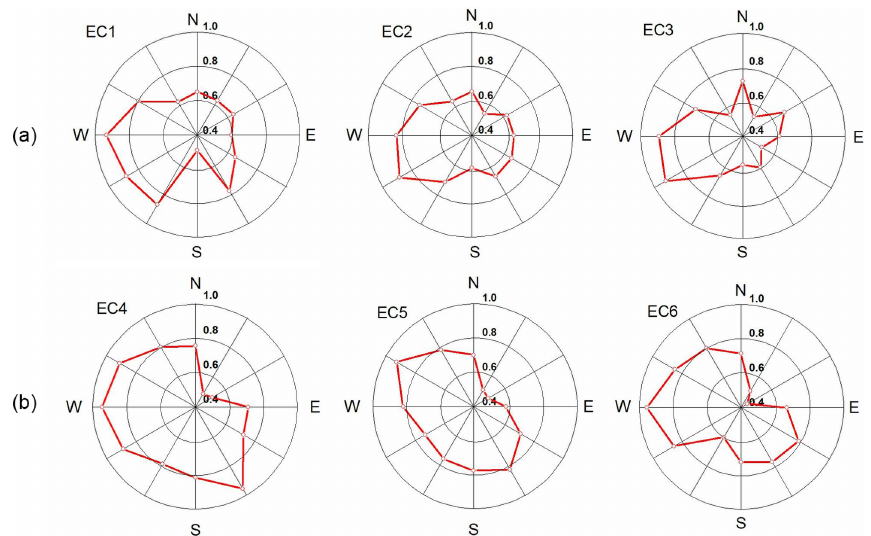
Figure 9. Half-hourly energy balance ratio (EBR) averaged for 30 ◦ wind sectors at the six eddy-covariance (EC) stations during the 2010 to 2017 study period. This is shown for (a) Kraichgau and (b) Swabian Jura.